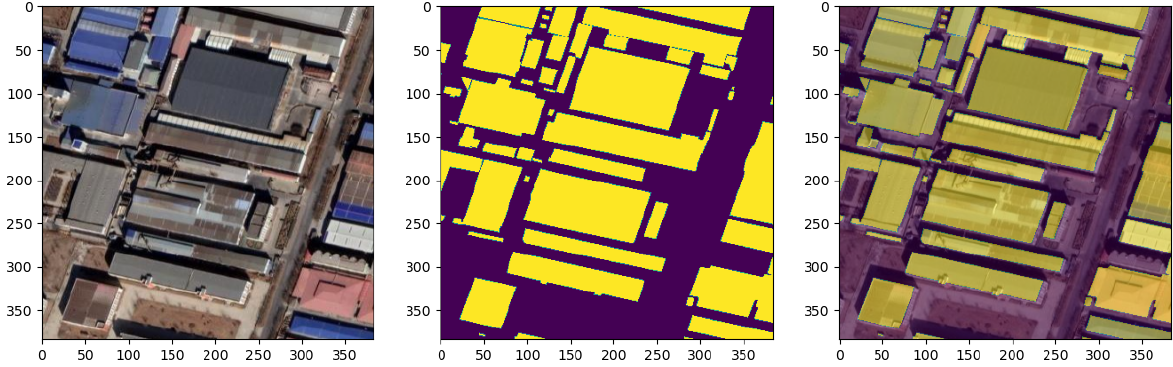
Figure 5. The slice results of Tianjin validation set.